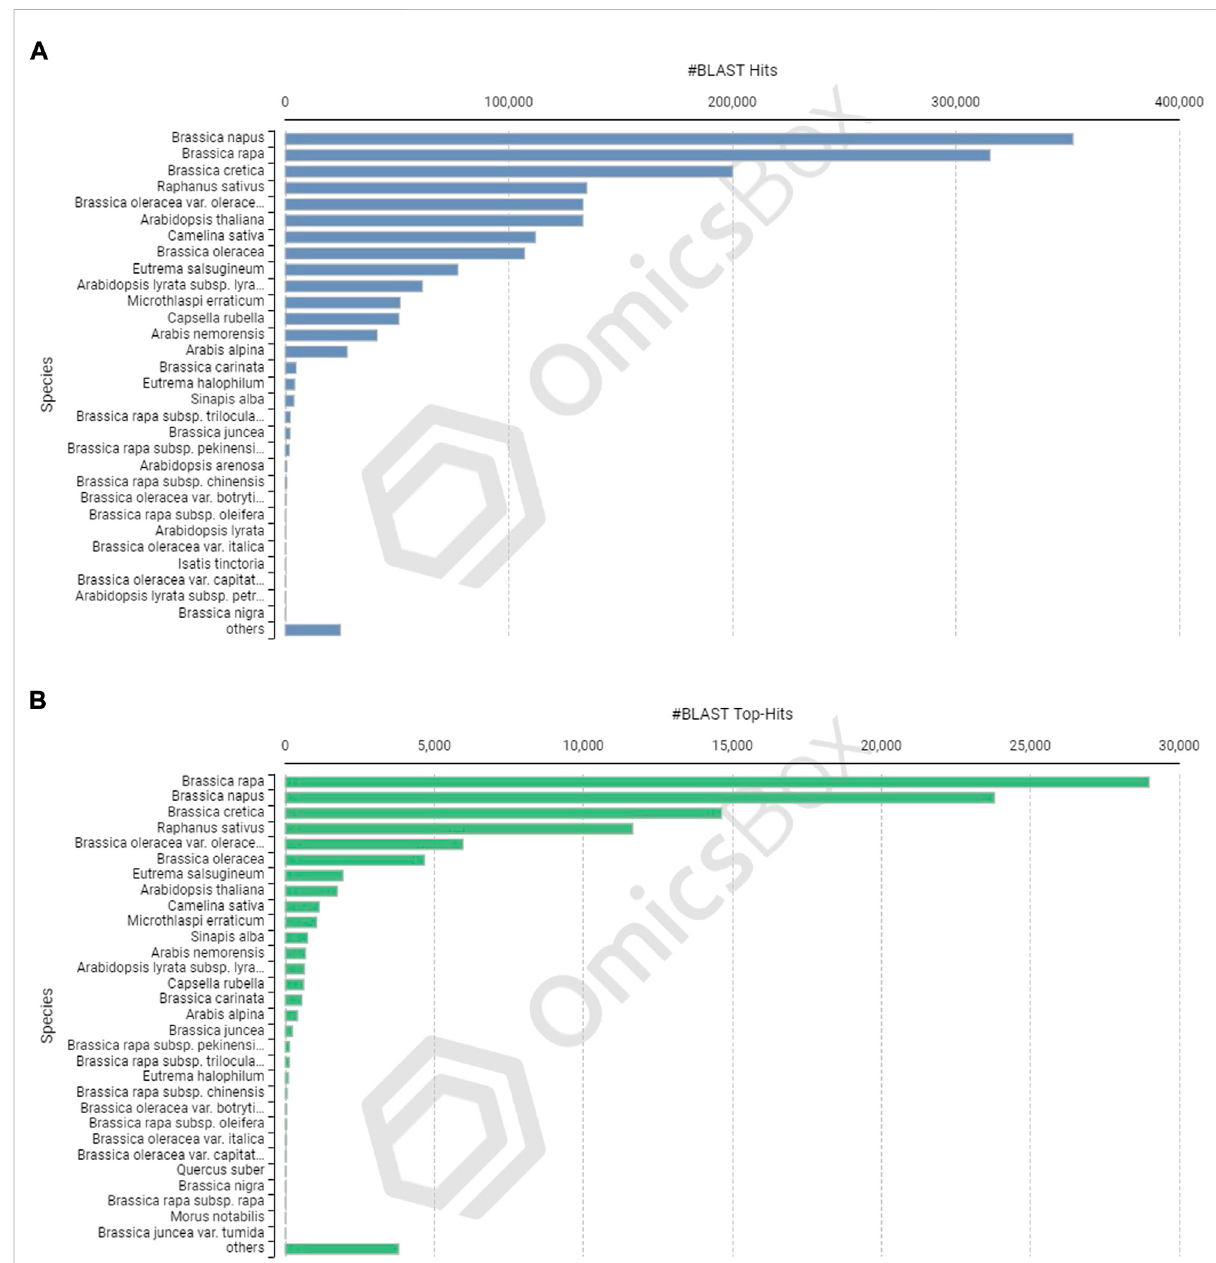
FIGURE 4 Species-based distribution of the BLASTX hits (A) and Top BLASTX hits (B) for each coding sequence of allohexaploid